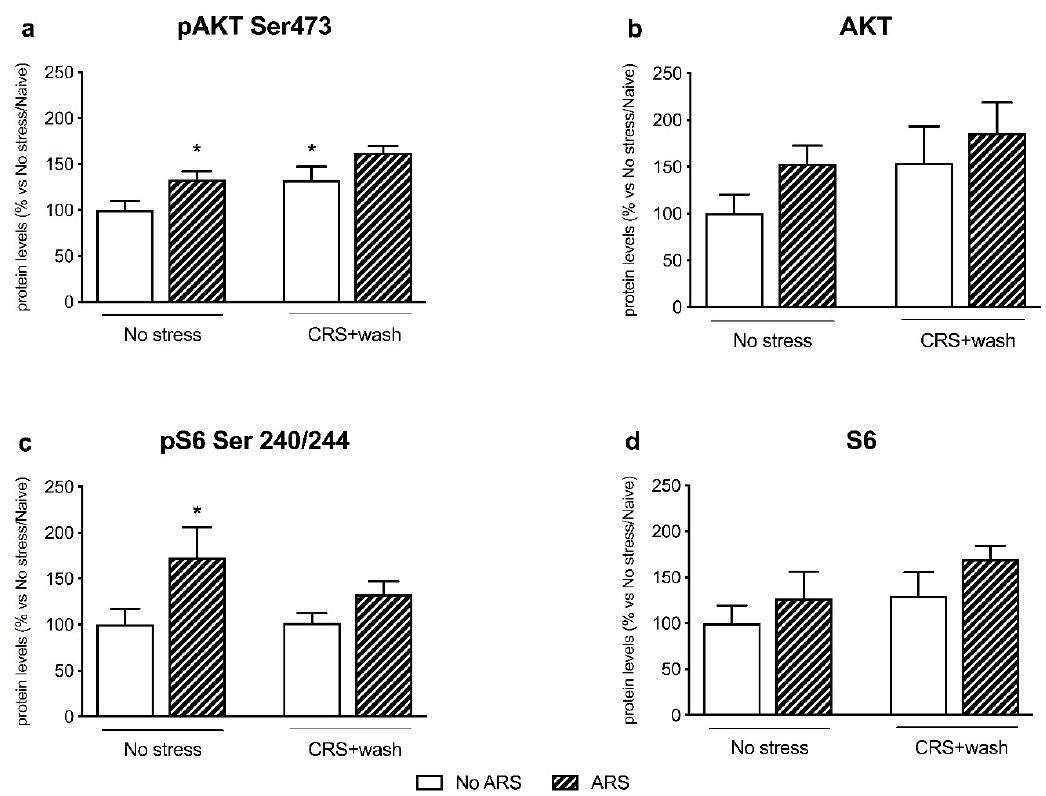
Figure 4. Analysis of AKT (panels a , b ) and S6 (panels c , d ) (phosphorylated and total) protein levels in the crude synaptosomal fraction of the prefrontal cortex of chronically stressed rats (CRS) exposed to an acute challenge (ARS) after 3 weeks of washout (wash). The data, expressed as a percent change of No stress / Naïve animals, are the mean ± SEM. * p < 0.05 vs. No stress / No ARS (two-way ANOVA with PLSD).